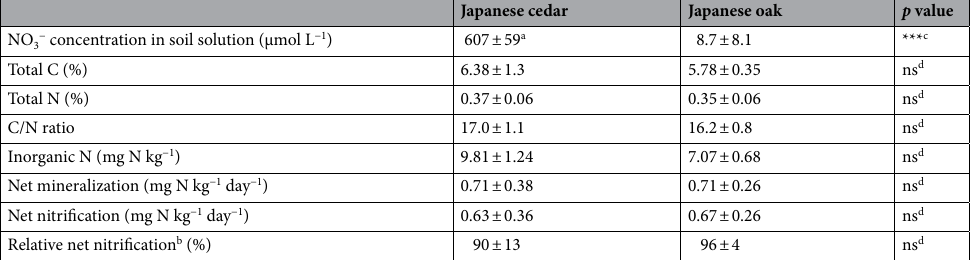
Table 1. Average NO 3− concentration in soil solution below rooting zone (50 cm depth), soil chemical properties of A layer (0–5 cm) in unfertilized plots of Japanese cedar and oak plantations during the study period from April to November 2018. a Mean ± standard error ( n = 5). b Defined as the proportion of net nitrification to net N mineralization. c Significant difference ( p < 0.001 for t -test). d No significant difference ( p > 0.05 for t -test).